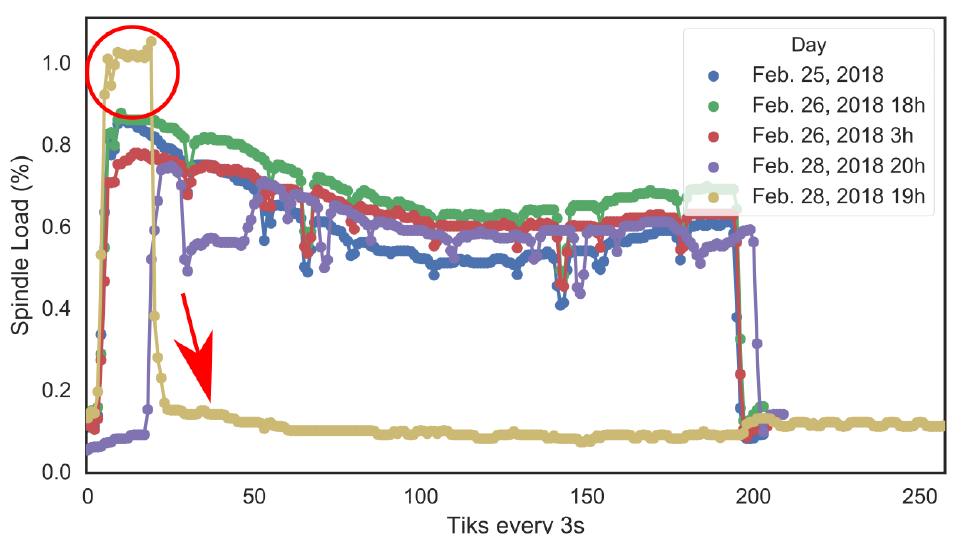
Figure 3. Spindle load through time compared with historical